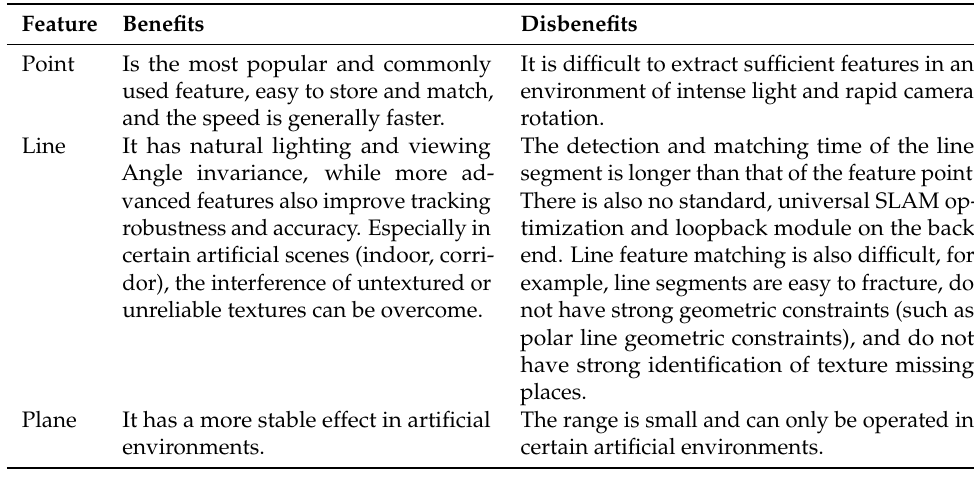
Table 4. Comparison table of geometric features.